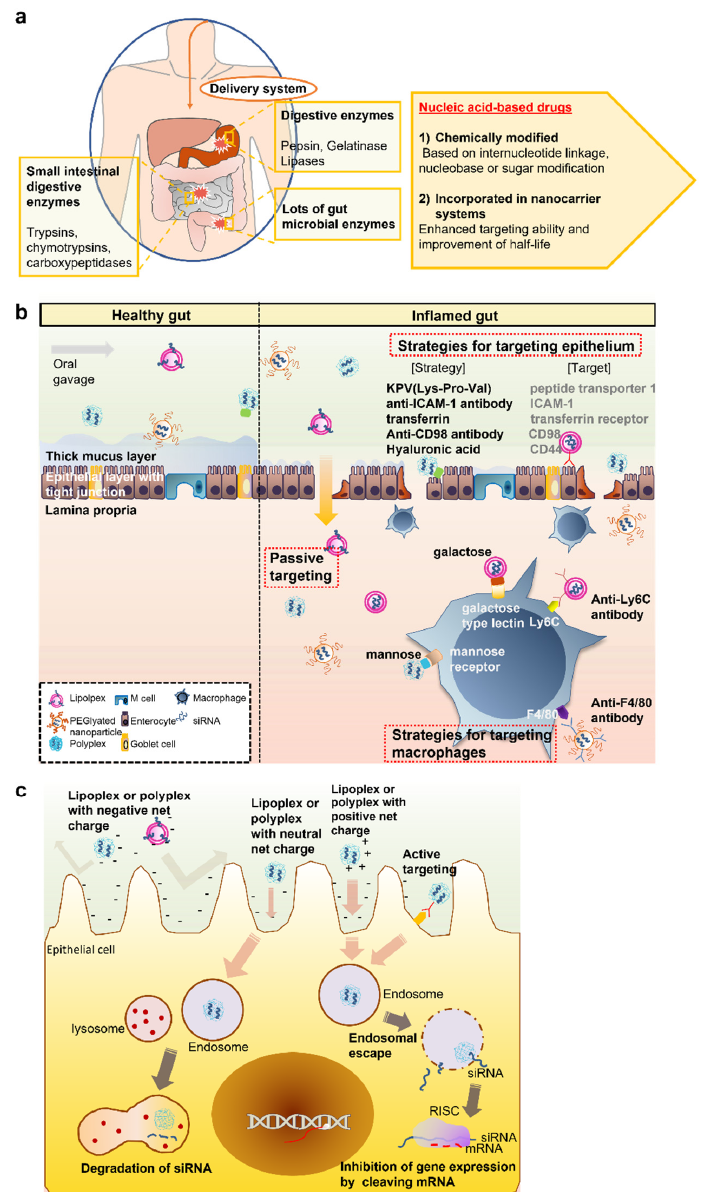
Figure 1. Physiological and biological barriers and strategies to orally deliver siRNA drugs. ( a ): Bio- chemical barriers and strategies to overcome them. siRNA can be degraded by various enzymes in the GI tract. Through chemical modification or encapsulation in nanocarriers, siRNA can be protected from degradation. ( b ): Intestinal barriers and strategies to overcome them. Tight junctions between epithelial cells and the thick, negatively charged mucus layer hinder the penetration of nanoparticles. However, in IBD patients, because of the significantly reduced mucus amount, the penetration of drug-loaded nanoparticles is much easier than through the mucus layer of the healthy gut. Forming a polyplex or lipoplex composed of cationic lipids with partial negative/neutral charges could be an effective way to overcome this limitation. Further functionalization for targeting ligands with intestinal epithelium and macrophages present on the nanoparticles could improve targeting to the site. ( c ): Cellular uptake barriers and strategies to overcome them. A high density of negative charges on the target cells prevents nanoparticles from penetrating cellular membranes. Even though nanoparticles are taken up by cells, siRNA can be degraded by lysosomal enzymes unless nanoparti- cles escape from the endosomes. A positive net charge of the polyplex or lipoplex can induce effective intracellular delivery with efficient endosomal escape activity. Nanoparticles with targeting ligands can be taken up by specific cells regardless of their